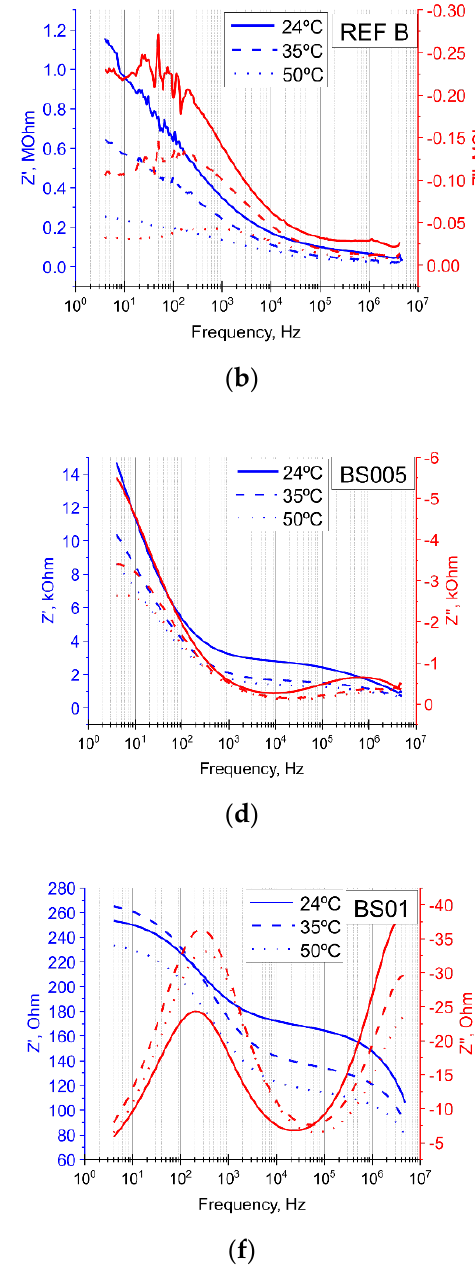
Figure 4. Bode plots for different mortars at different sample temperatures. ( a ) REF-A; ( b ) REF-B;